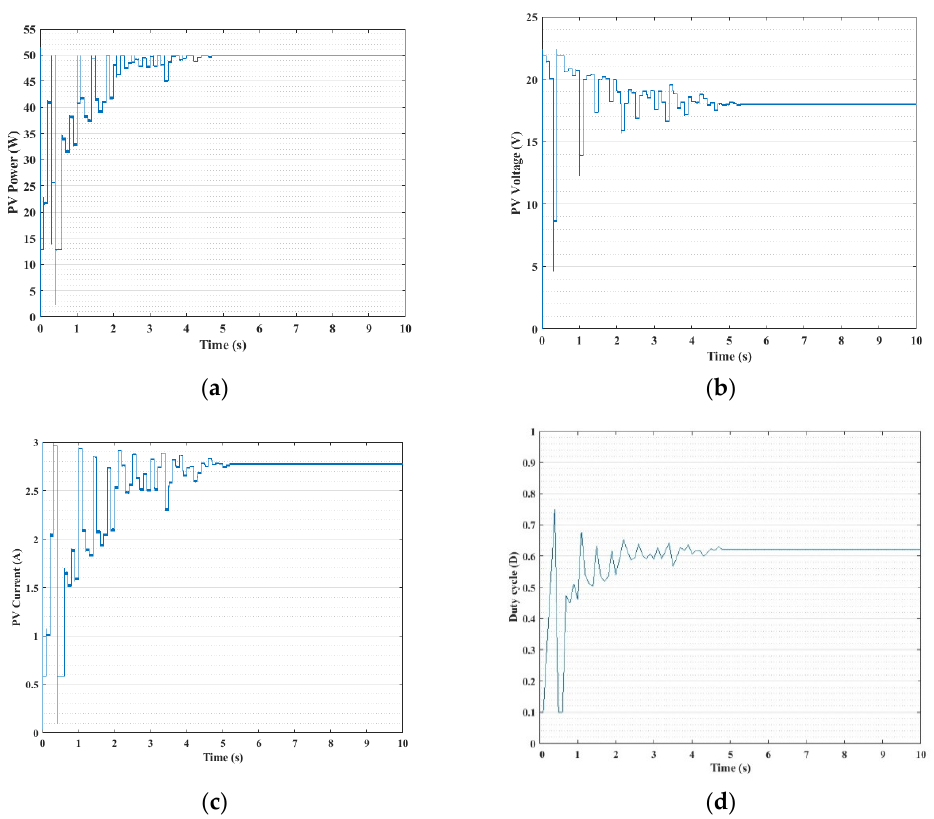
Figure 10. Modified LFO at 1000 W/m 2 irradiance ( a ) power ( b ) voltage ( c ) current ( d ) duty cycle.